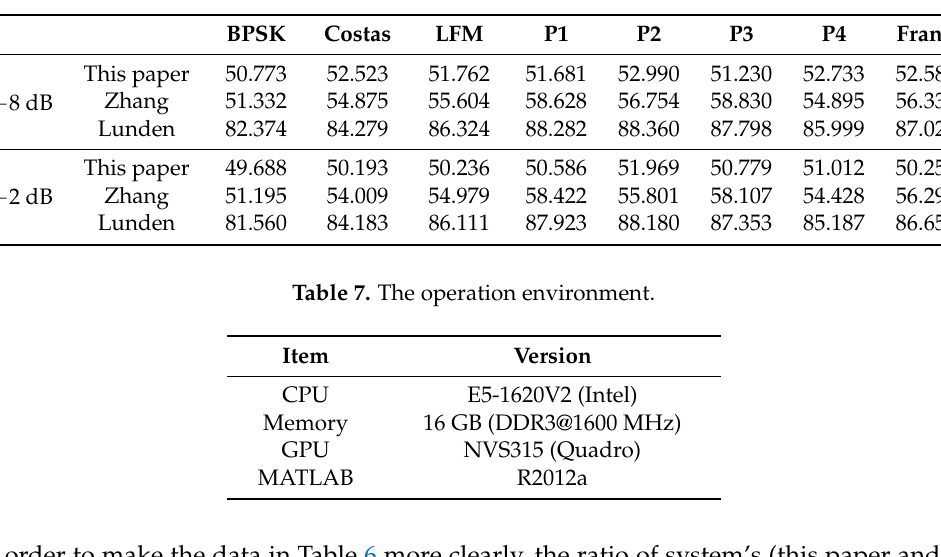
Table 6. The time of this paper, Zhang’s and Lunden’s.